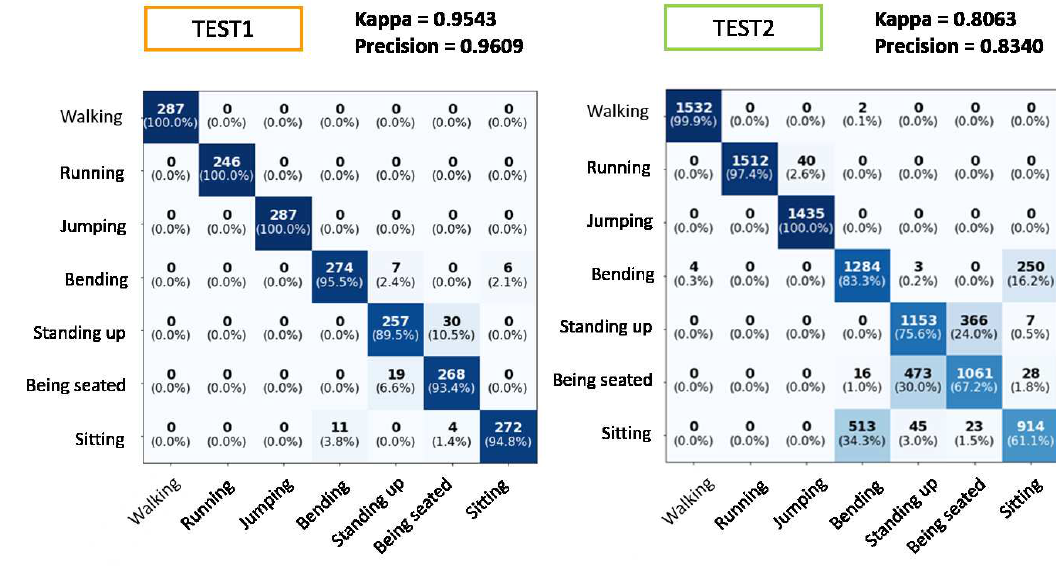
Figure 12. Confusion matrix for normal activities classification. TEST1: Data test set separated from training set. TEST2: Test set regarding the player not introduced in training. Rows true label and columns the predicted